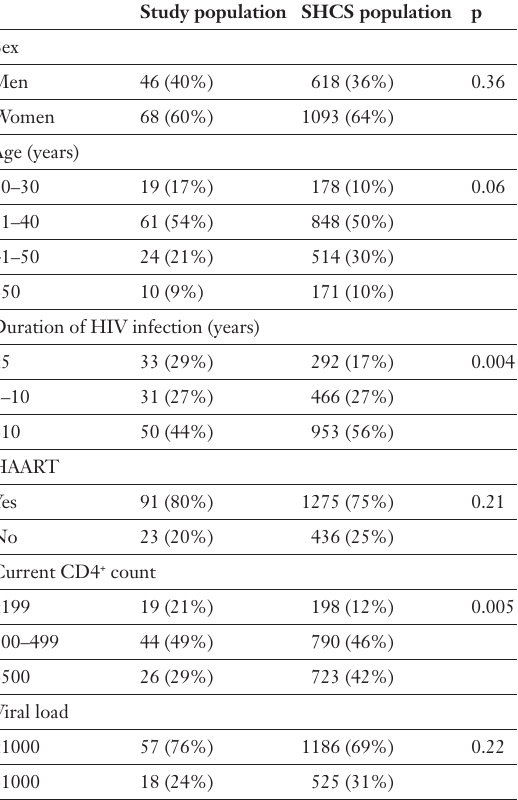
Comparison between study and SHCS population – sociodemographic